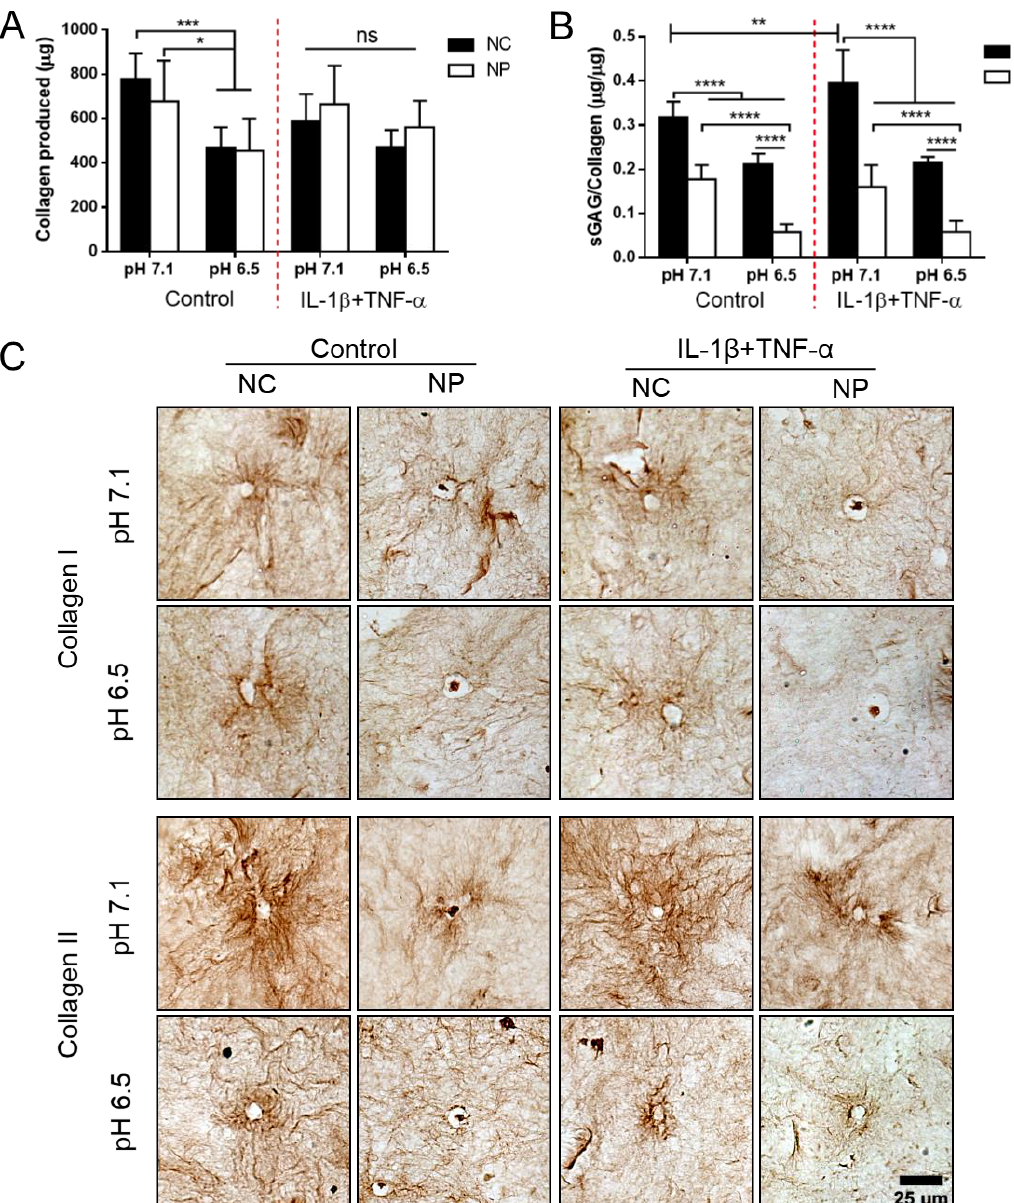
Figure 7. ( A ) Total collagen (μg) produced in hydrogels containing NCs and NP cells in 3D hydrogel culture at different pH (7.1 and 6.5) and inflammatory cytokine (IL-1β+TNF-α) supplementation conditions. ( B ) sGAG:Collagen ratio. Both quantities were calculated as respective amounts produced over 14 days by subtracting day 0 content from day 14. * ( p < 0.05), ** ( p < 0.01), *** ( p < 0.001) and **** ( p < 0.0001) indicate significant differences between groups, ns (not significant) indicates p ≥ 0.05. N = 3 donors, n = 3 samples. ( C ) Collagen type I and collagen type II immunohistochemical staining. Scale bar is 25 μm.